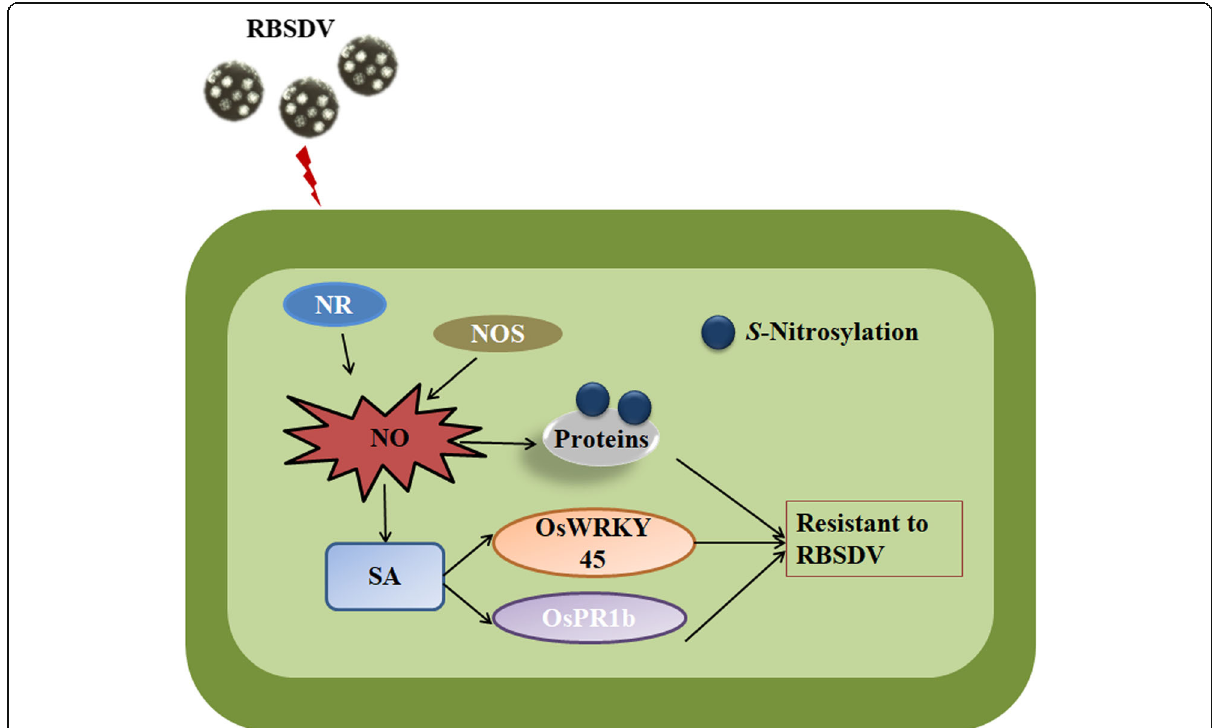
Fig. 7 A working model for NO-dependent rice resistance to RBSDV infection. RBSDV infection in rice plants causes an early NO burst. The accumulated endogenous NO catalyzed by NR and NOS activities, acts as an inducer to trigger SA production. The accumulated SA up-regulates the expressions SA responsive host defense genes, thus leading to rice resistant to